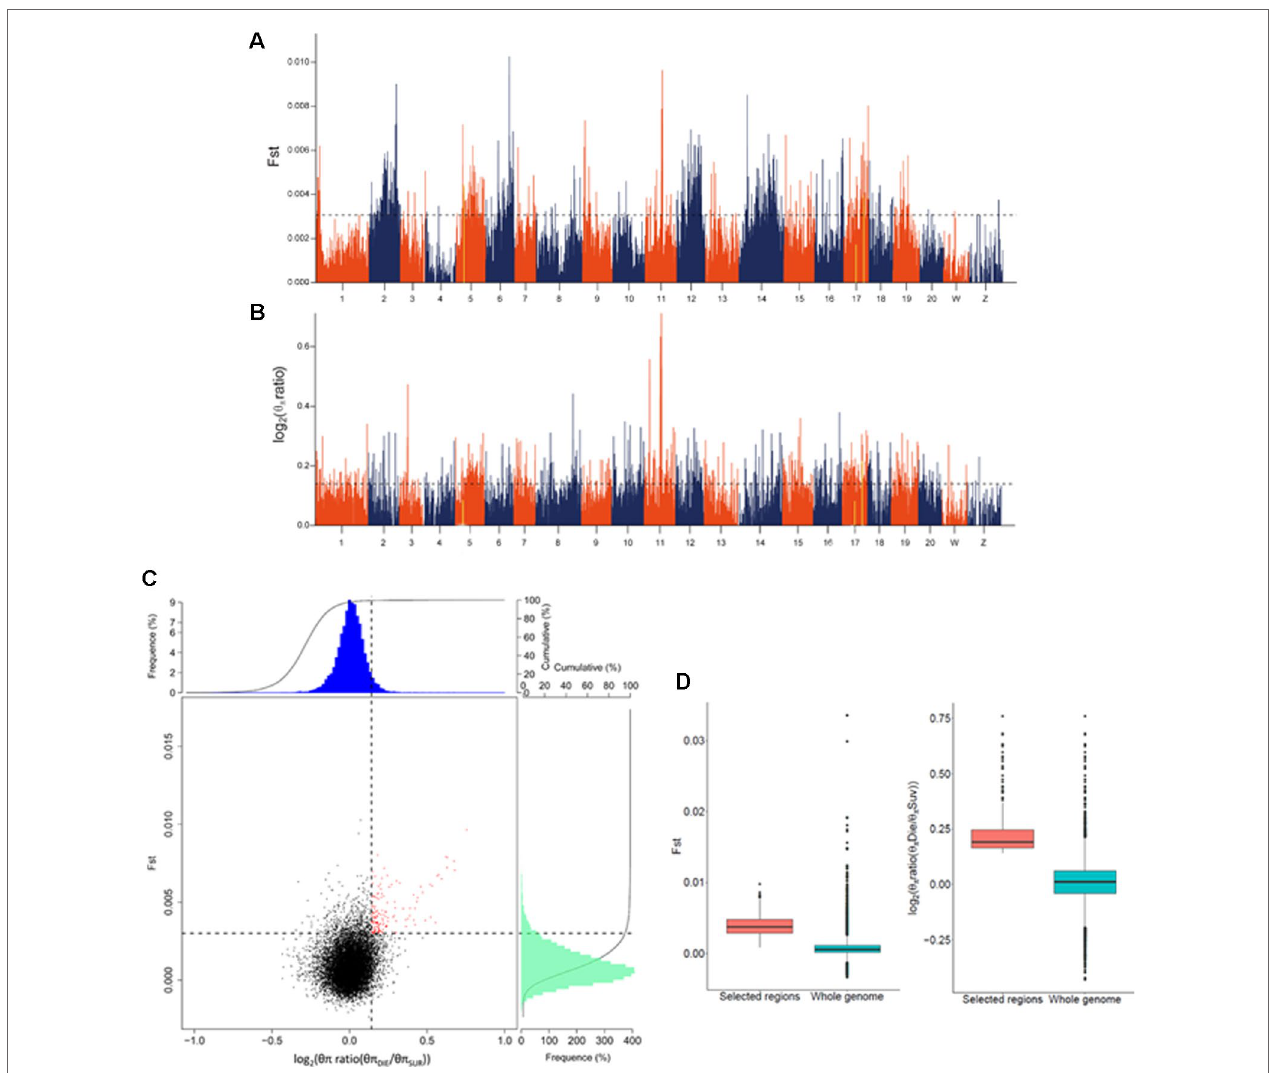
FiGURE 2 | Genome-wide screening of genomic regions with Fst and nucleotide diversity estimation for disease resistance in Cynoglossus semilaevis . (A) Distributions of Fst , which were calculated in 40 kb windows with a 20 kb step. The dashed horizontal line corresponds to 5% top values. (B) Distributions of log 2 [ θπ ratio ( θπ DIE / θπ SUR )]. The dashed horizontal line corresponds to 5% top values. (c) Distributions of log 2 [ θπ ratio ( θπ DIE / θπ SUR )] and Fst . The red points (corresponding to the overlaps of top 5% log2 (θπ ratio) and Fst values) were identified as candidate regions. (D) The candidate regions exhibited a significantly higher Fst and log 2 ( θπ ratio), compared to the whole genomic background ( p < 10 −16